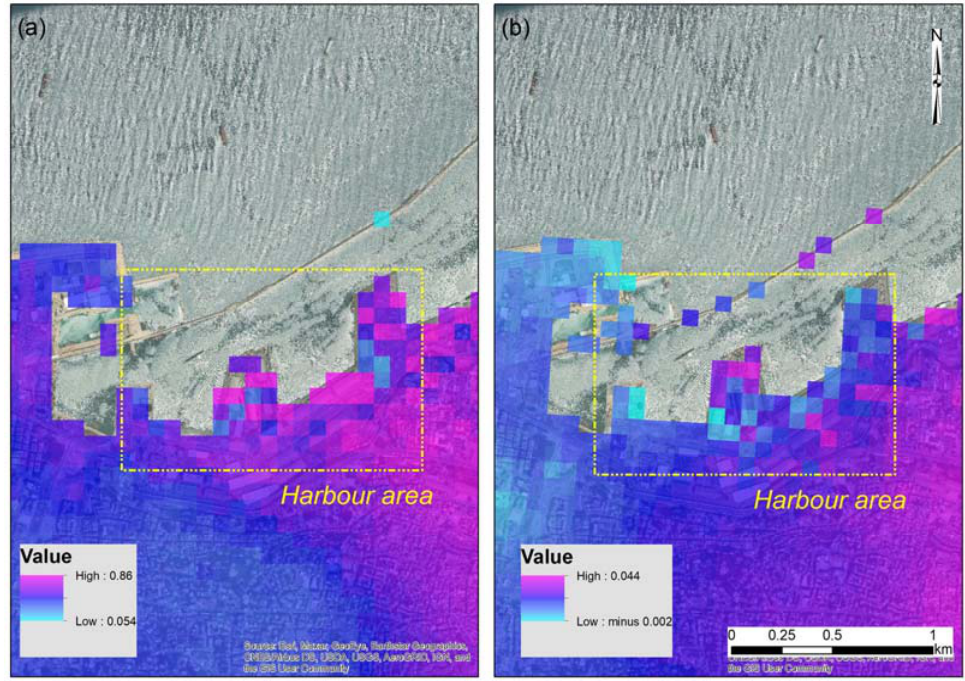
Figure 7. ( a ) Line of sight (LOS) displacements as derived from the Sentinel ‐ 1 SAR images (descending orbit). Harbor area, as indicated in a yellow square. ( b ) Line of sight (LOS) displacements as derived from the Sentinel ‐ 1 SAR images (ascending orbit). Harbor area, as indicated in a yellow square.